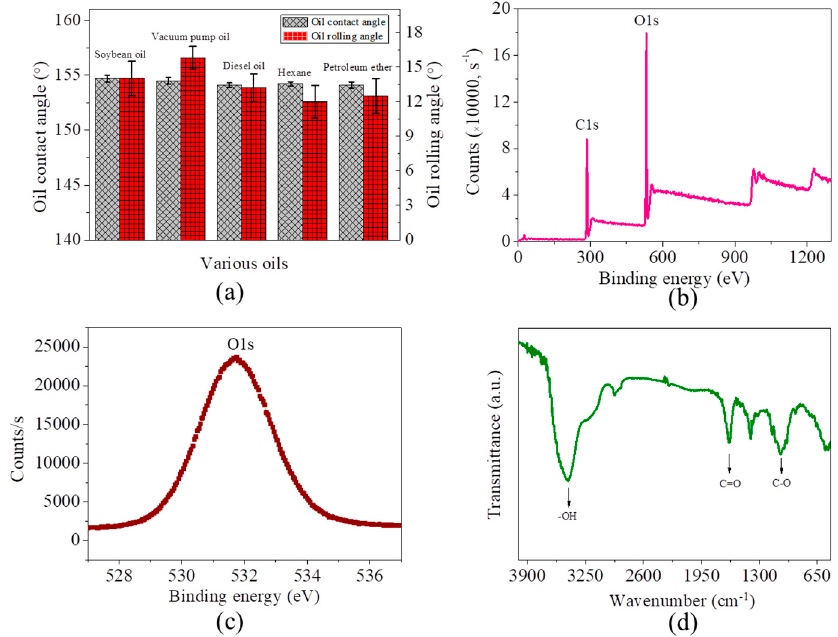
Figure 3. ( a ) Contact angles and rolling angles of five kinds of oils on the microfiber filter in water; ( b ) Oxygen content analysis of the microfiber filters by XPS; ( c ) Symmetric O1s peak centered at 531.6 eV; ( d ) Identification of chemical groups on the microfiber filters by FTIR.